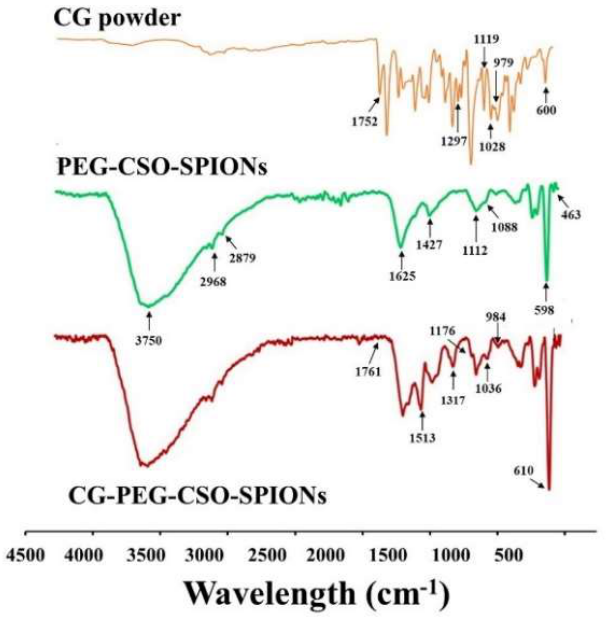
Figure 5. Representative FT-IR spectra of the CG powder; PEG-CSO-SPIONs and